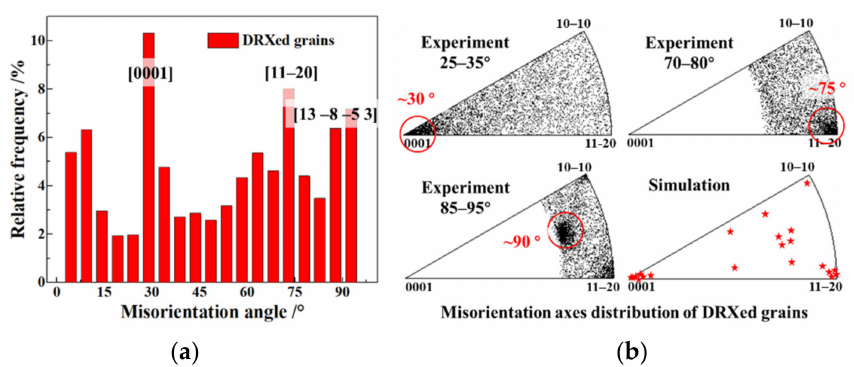
Figure 10. Analysis of GBs misorientation of recrystallised grains of the TA15 tensile samples (800 ◦ C– 0.001 s − 1 –true strain 0.3). ( a ) Misorientation; ( b ) experimental and simulated distribution of misori- entation axes. Under the tensile deformation condition of 800 ◦ C–0.001 s − 1 of the TA15 tensile sample, the simulated distribution of stress, strain and dislocation density of DRX behaviour in the white dashed box of Figure 9a are shown in Figure 11. The dislocation density in the GB region, due to the significantly greater value than that of the α and β phases, is not shown on the distribution cloud map of dislocation density, as shown in the gray area of Figure